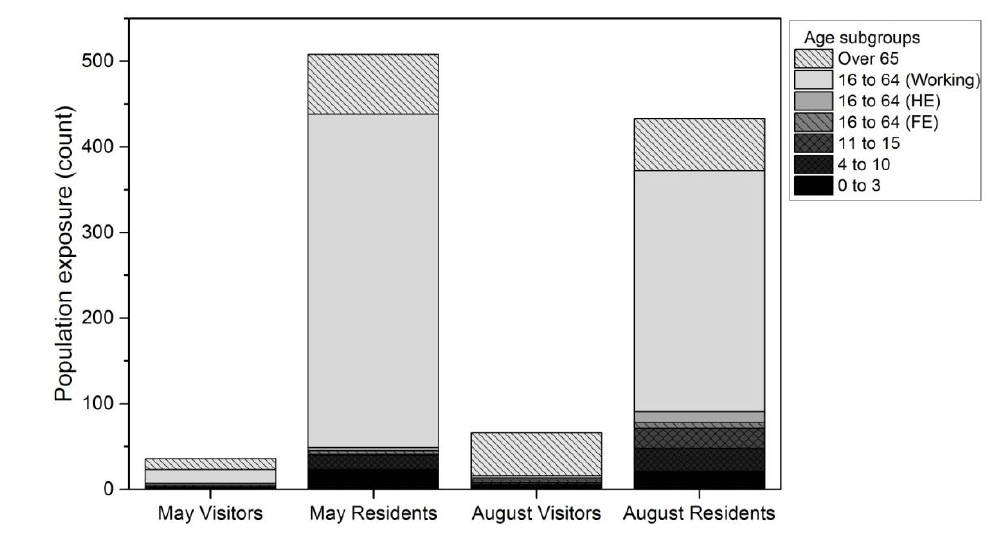
Figure 10. Comparison of daytime (12:00) population LISFLOOD-FP R100 exposure estimates broken down into age subgroups for visitors and residents in May and